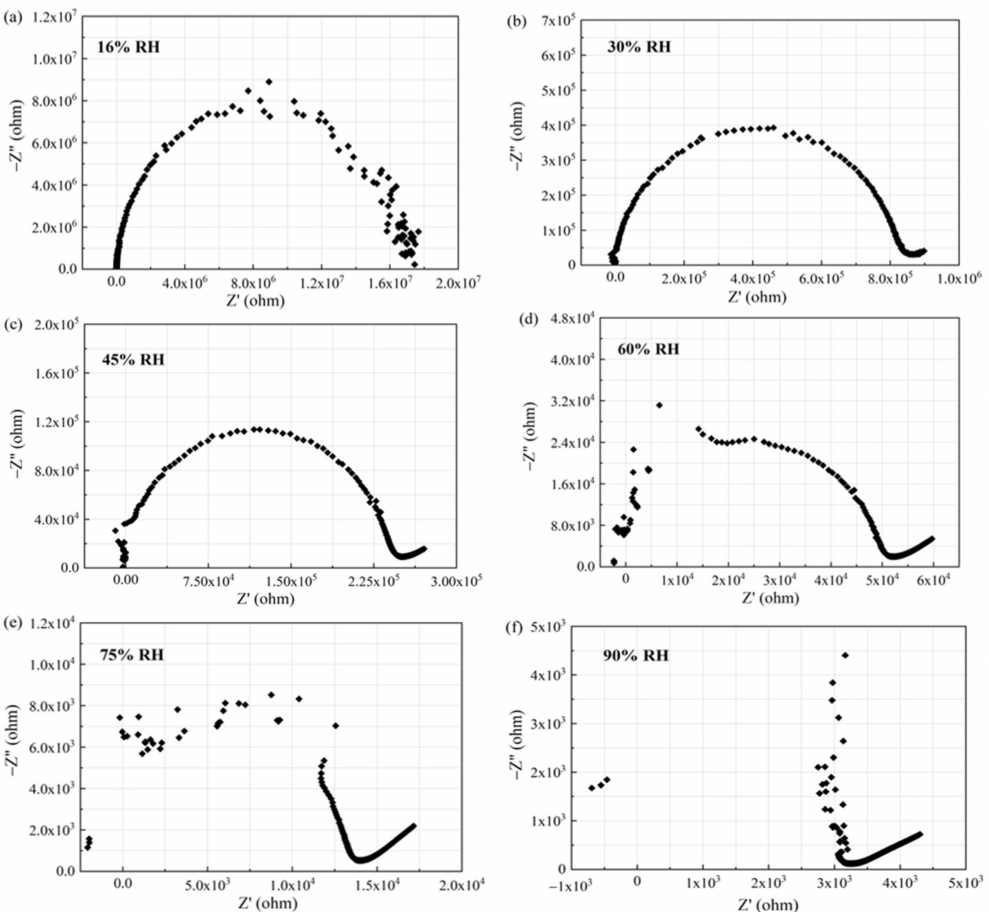
Figure 15. Complex impedance plots of the sensor based on ethanol-treated hydrophobic PTFE substrate under different humidity levels: ( a ) 16% RH, ( b ) 30% RH, ( c ) 45% RH, ( d ) 60%RH, ( e ) 75% RH, ( f ) 90% RH.